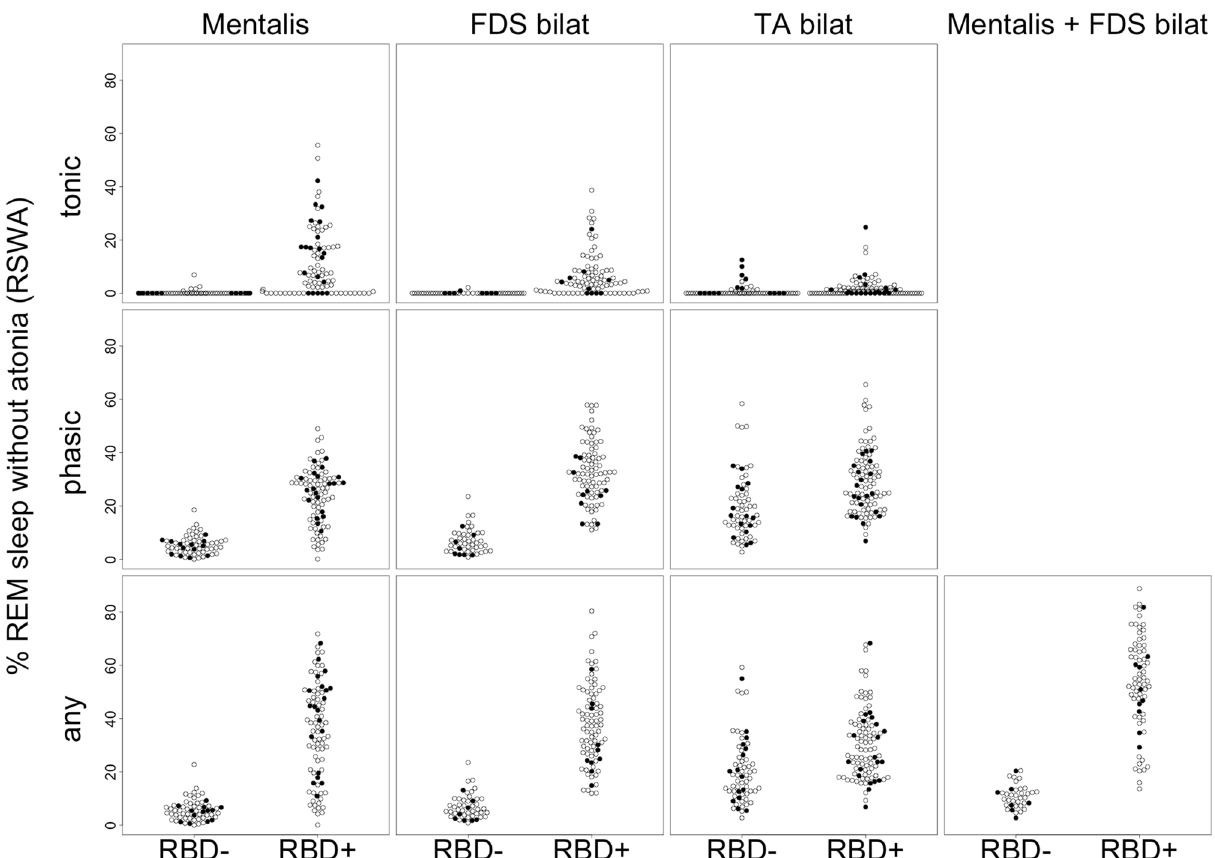
Figure 2. Dot plots of individual tonic (upper row), phasic (middle row), and (any) percentage of rapid eye movement (REM) sleep without atonia after removal of arousals, snoring and technical artefacts in mentalis EMG and combination of FDS and TA EMG channels of both sides as well as the combination of mentalis EMG and combined FDS EMG channels. Subjects without RBD (RBD-, patients with Parkinson’s disease marked as black dots) are presented on the left, and subjects with RBD on the right (RBD +). FDS flexor digitorum superficialis muscle, TA tibialis anterior muscle, R right, L